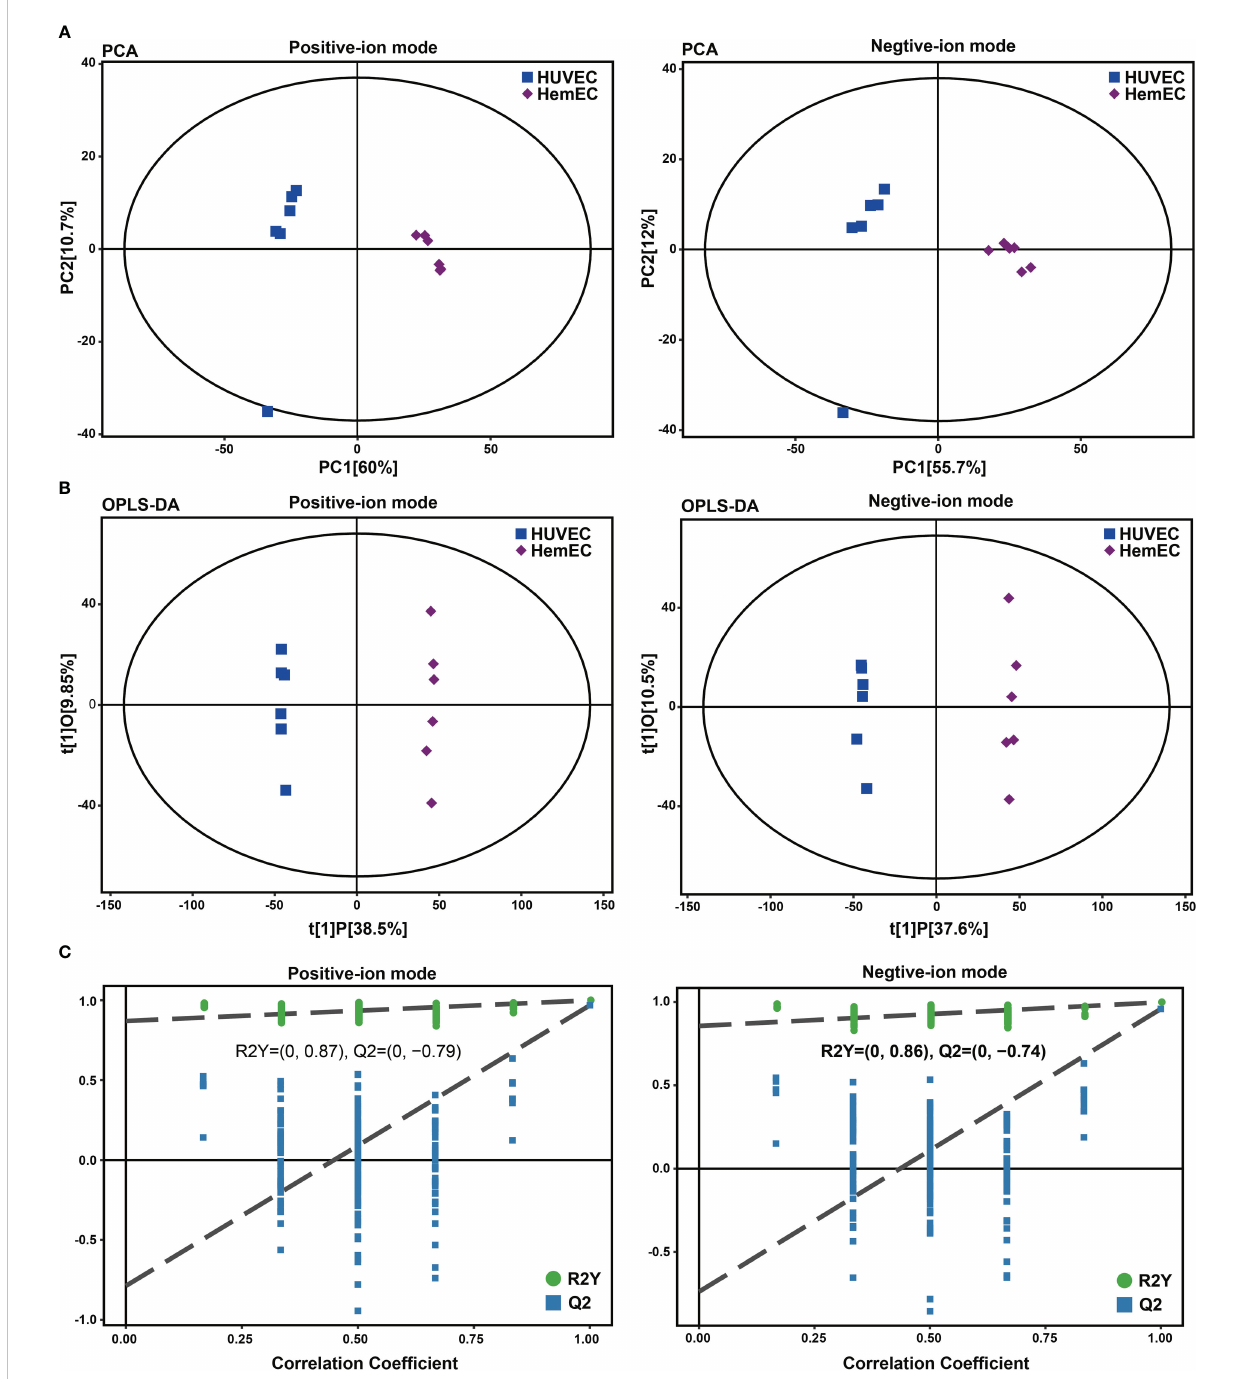
FIGURE 1 Score plots of principal component analysis (PCA), orthogonal partial least squares discriminant analysis (OPLS-DA) and single-dimensional statistical analysis between the HUVEC group and HemEC group by nontargeted metabolic analysis. (A) PCA score plots between HUVECs and HemECs in both positive-ion and negative-ion modes. (B) OPLS-DA score plots between HUVECs and HemECs in both modes. (C) Permutation tests consisting of 200 permutations demonstrated that the OPLS-DA model was not over fi tted in either